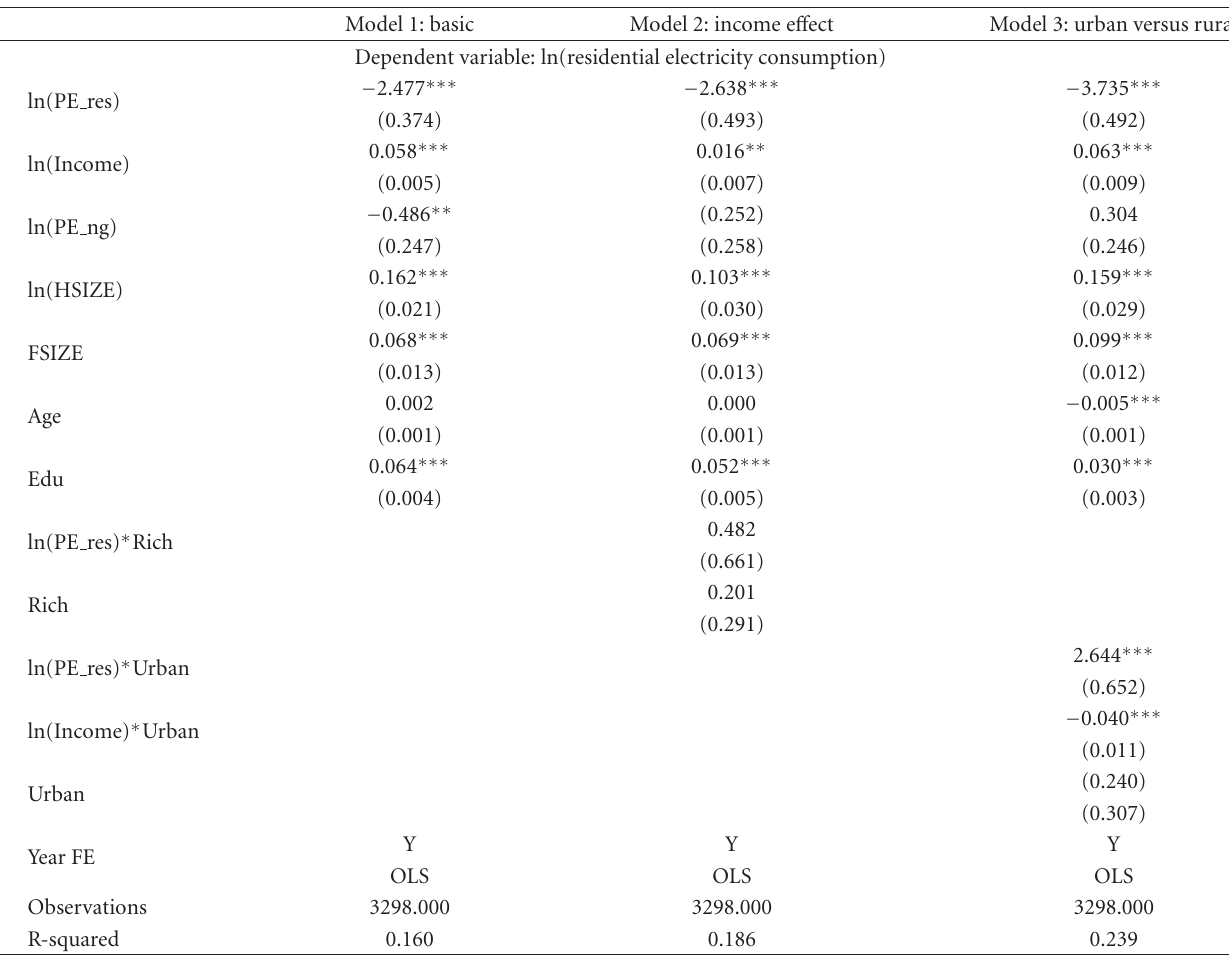
Table 2: Estimation results using OLS